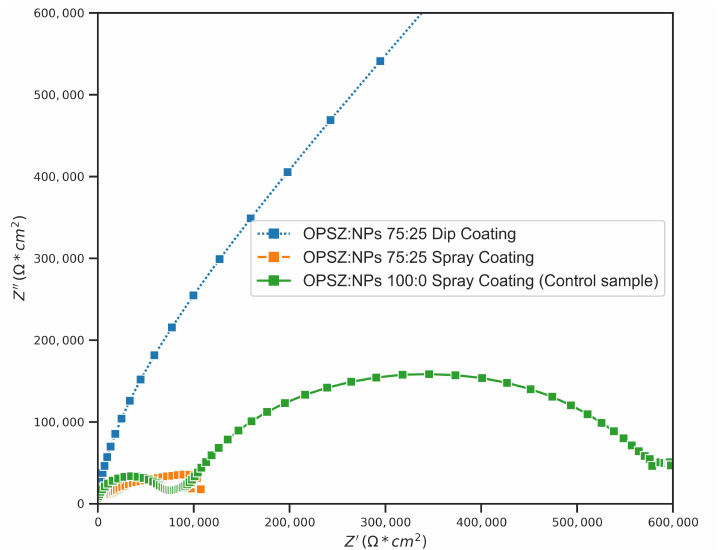
Figure 14. Nyquist Figure 14. Nyquist plot.